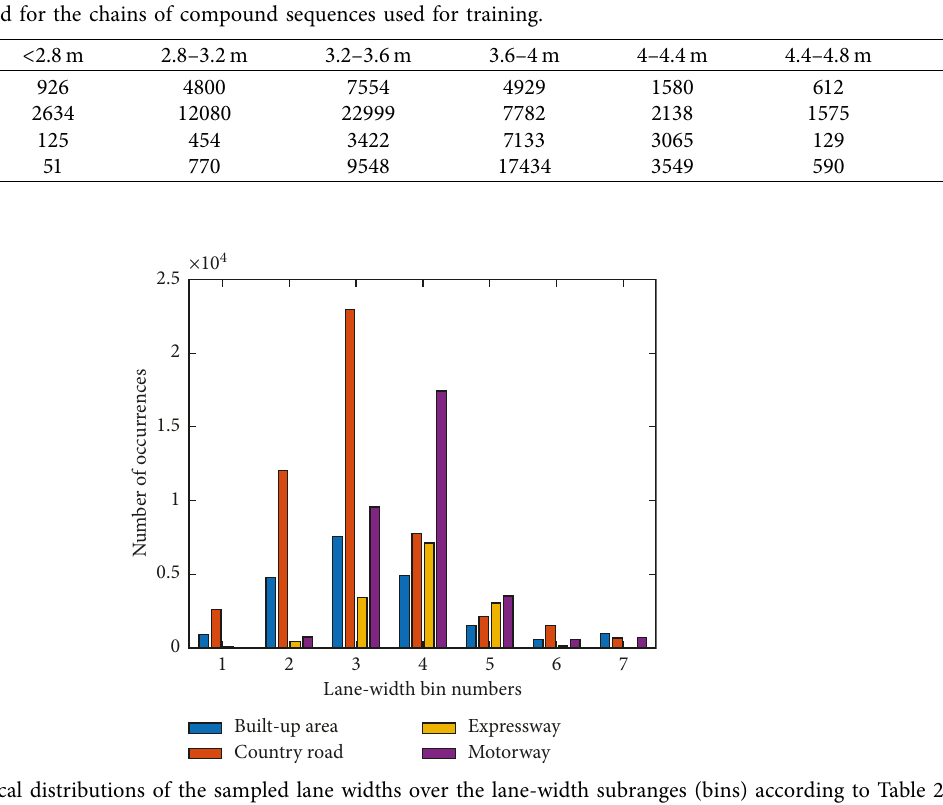
Figure 2: Empirical distributions of the sampled lane widths over the lane-width subranges (bins) according to Table 2. Table 3: The “scores”—associated with the lane-width “bins” shown in Table 2—used in the proposed RTD method. Lane-width